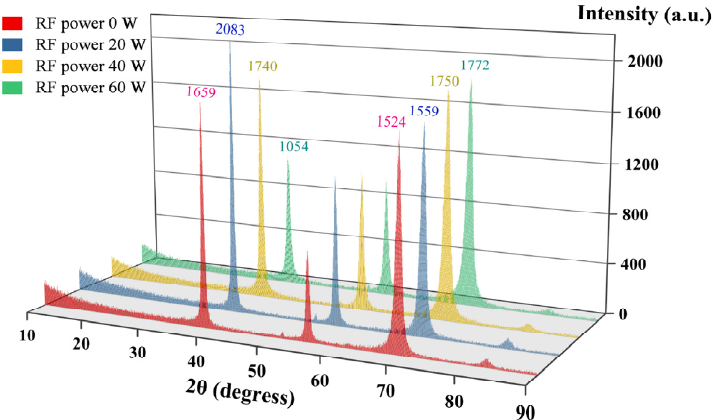
Figure 5. XRD patterns of the Nb films deposited under various RF bias powers.